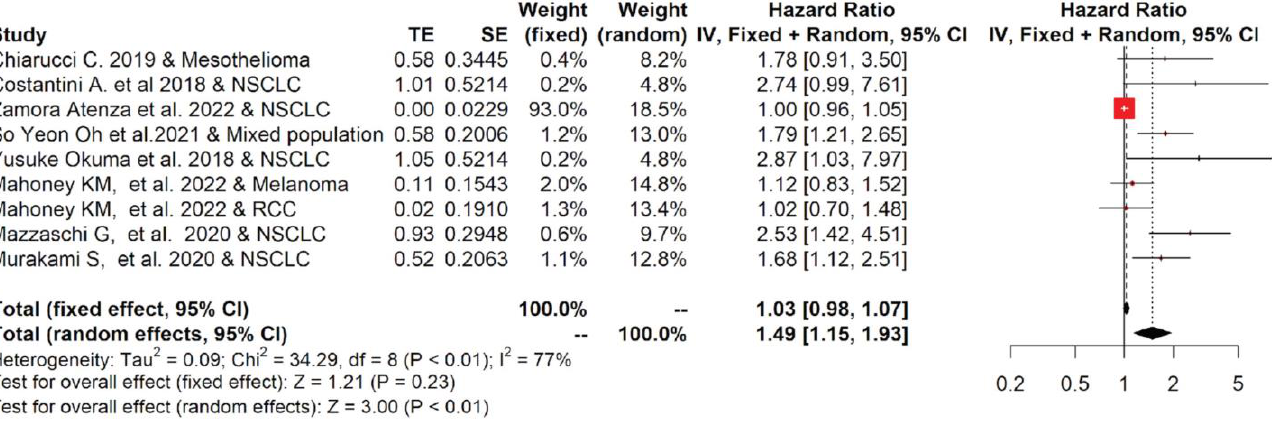
Figure 2. Overall pooled HRs comparing the high- versus the low-PD-L1 values group for OS in patients with solid cancer treated with immunotherapy. The column study indicates the reference (from which we extracted or calculated the HR and 95% CI) and the investigated tumor type [18,20,22 – 28].